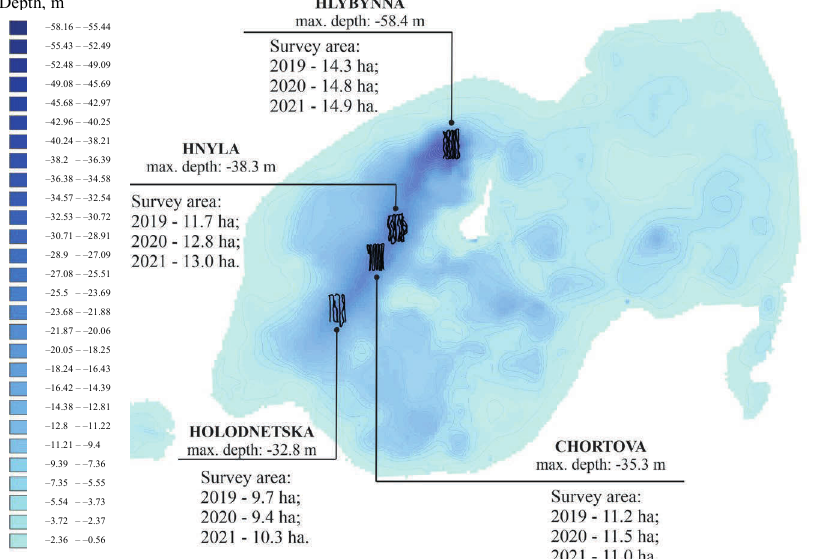
Fig. 1. Areas of bathymetric surveys within the deepest sinkholes of Svitiaz